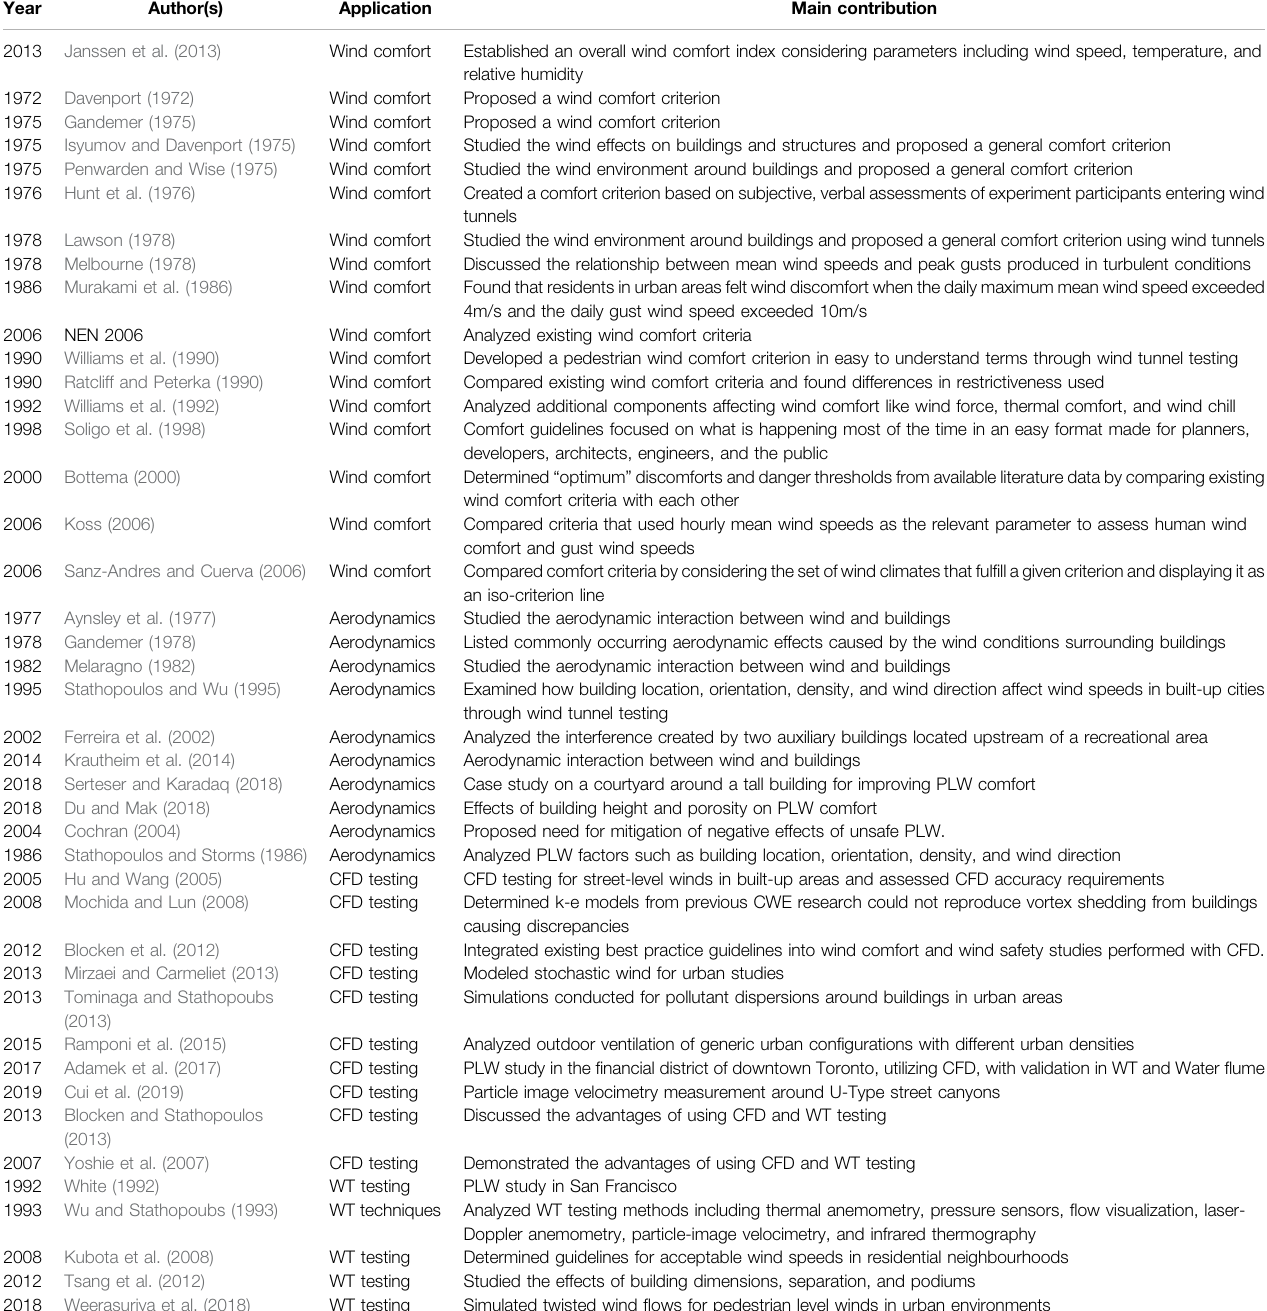
TABLE 1 | Summary of previous